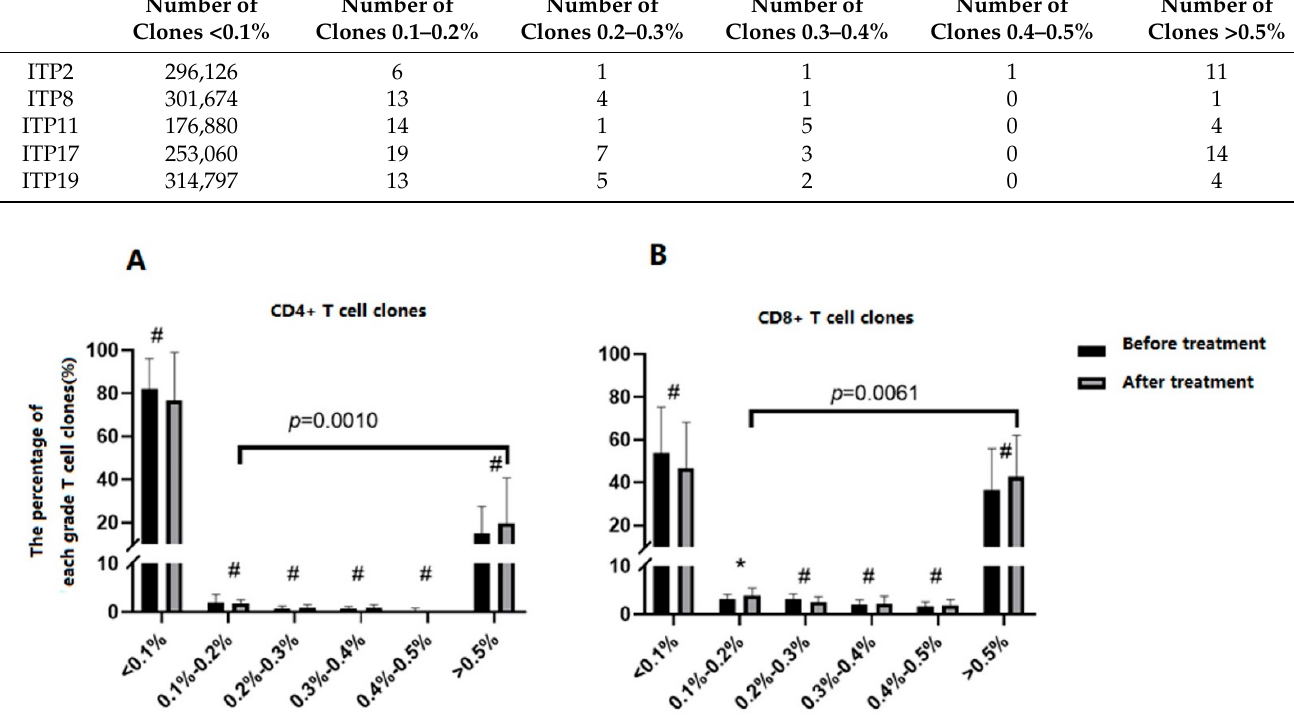
Figure 3. The clone distribution of ITP patients’ CD4 + T and CD8 + T cells after treatment, and the comparison with the distribution before treatment. One Way ANOVA and Kruskal Wallis test were used for data fulfilled normal distribution and for those did not, respectively. ( A ) CD4 + T cell clones; ( B ) CD8 + T cell clones. #: p > 0.05 when the percentage of T cell clones before treatment compared with the correspondent T cell clones after treatment; *: In the CD8 + T cells, the number of clones of 0.1–0.2% grade increased after treatment, p = 0.0431. After treatment, the number of CD8 + TCR clones was (268427.20 ± 120730), similar to the base level ( p = 0.2249). Most clones (268357.00 ± 120752.43) were low-frequency ones (<0.1% of total TCR analyzed, Table 6). The percentage of TCR CDR3 in each grade was shown in Figure 3B. The percentage of grade (0.1%–0.2%) was higher than that before treatment ( p = 0.0431), and other grades didn’t differ. The percentage of high-frequent clones (>0.5%) was higher than other 4 grades ( p = 0.0061), excluding the mini size of clones (<0.1%). Table 6. The distribution of CD8+ T cell repertoire in peripheral blood after